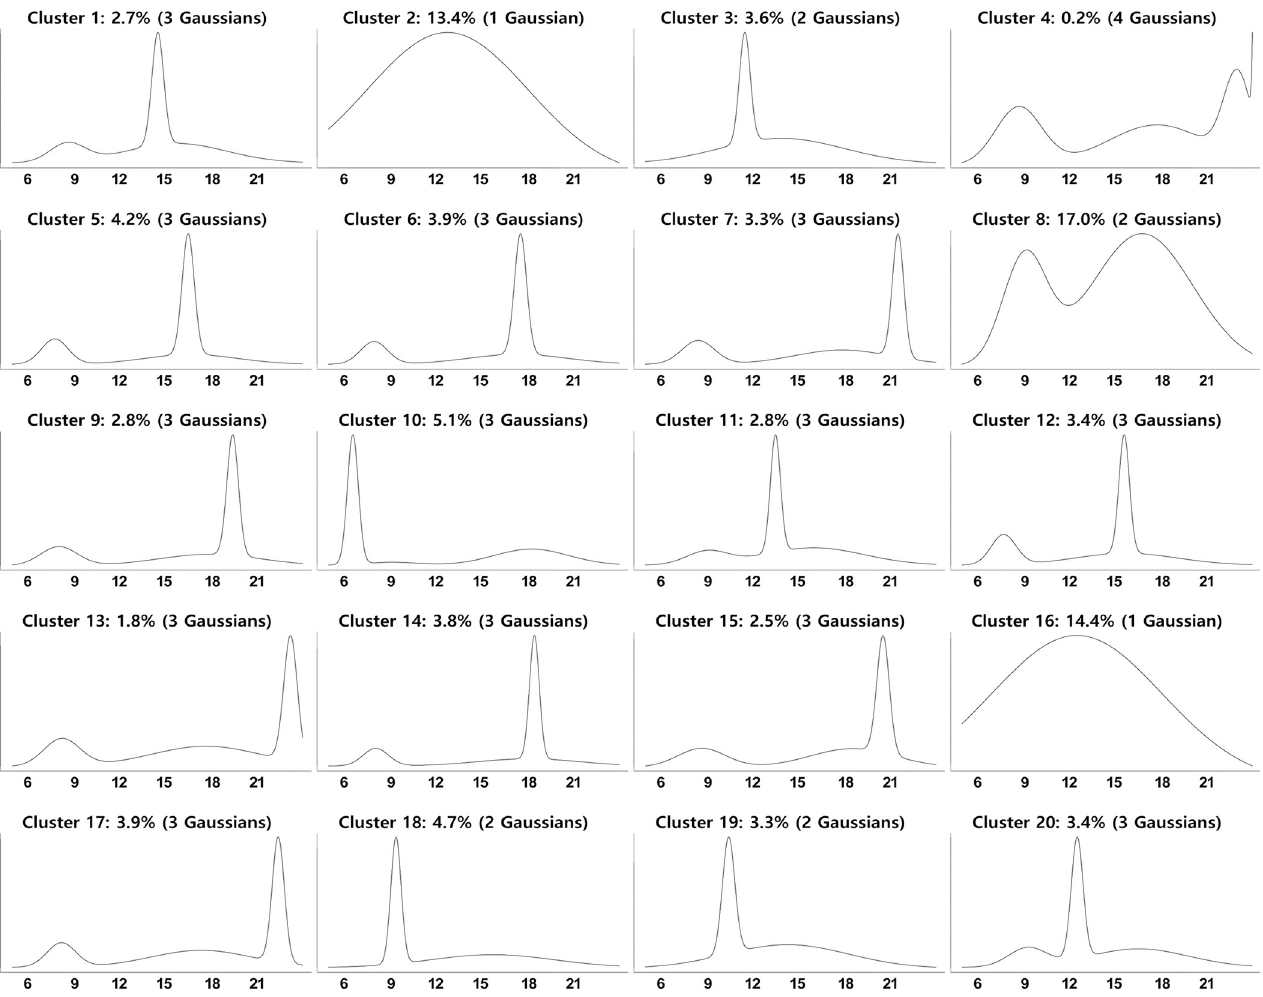
Fig 9. Temporal boarding time pattern of each cluster. Note: Each graph shows the boarding density over time for each of the 20 clusters.